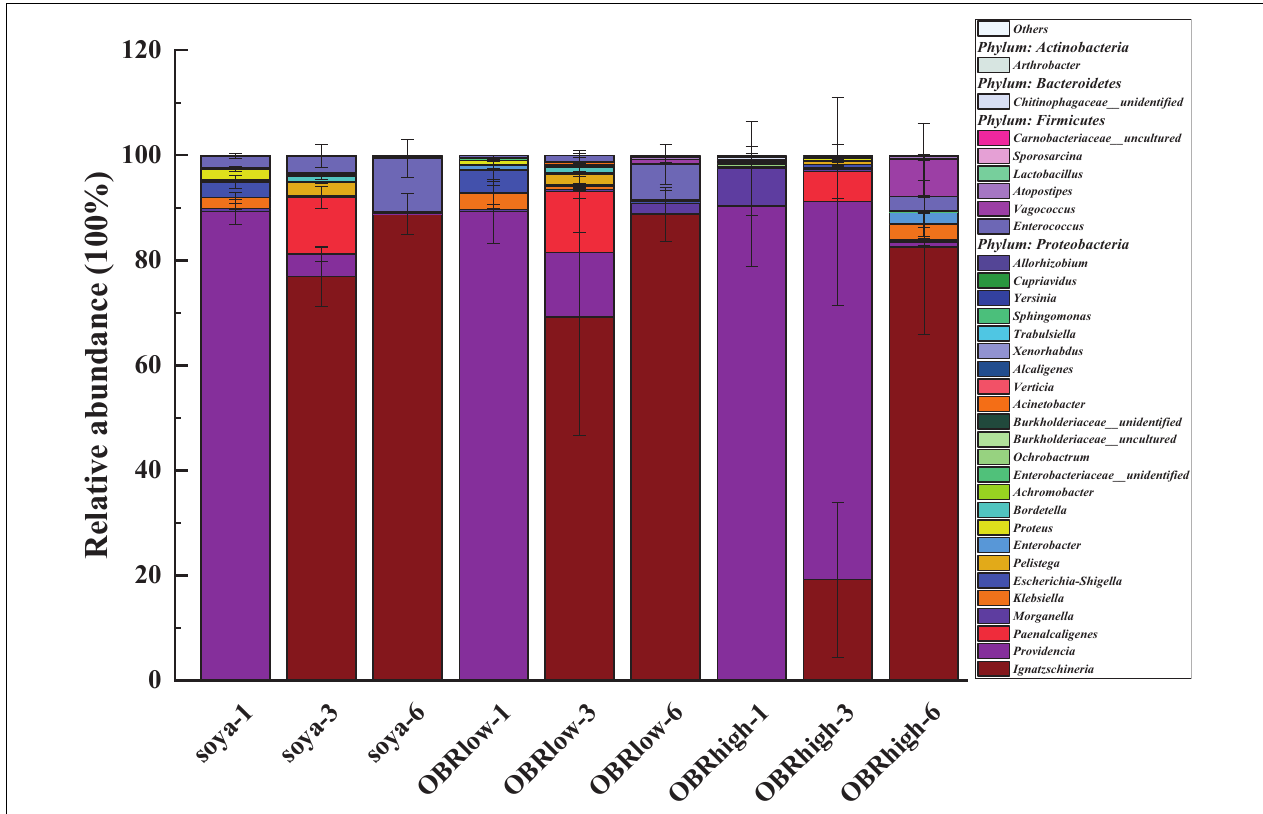
FIGURE 4 | The genus-level composition (mean, n = 3) of the larval gut microbiota. Only the most abundant taxa ( > 0.1% genus) are shown (mean, n = 3). The soya, OBRlow, and OBRhigh represent treatments containing only soybean meal, a low amount of OBR, and a high amount of OBR, respectively, 1, 3, and 6 represent the first, third, and sixth day,